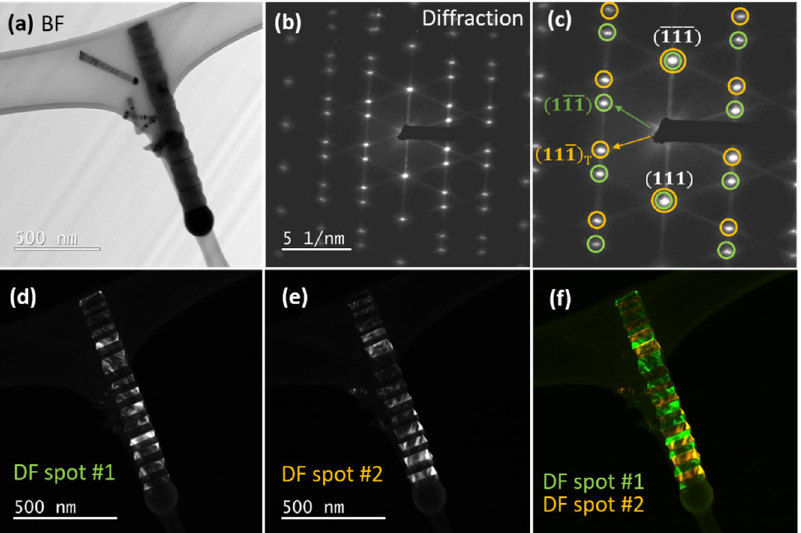
Figure 15. ( a ) bright-field TEM image of a single NW; ( b ) selective area electron diffraction pattern of the NW indicating a ZB twinning symmetry, ( c ) marked diffraction twinning spots with green and orange circles; ( d ) dark field (DF) image with spot #1 (green) highlighting segments from one ZB orientation; ( e ) DF image created from spot #2 (orange) highlighting segments from the other ZB orientation; ( f ) composite DF image made of ZB segments with two different orientations marked in green and orange.